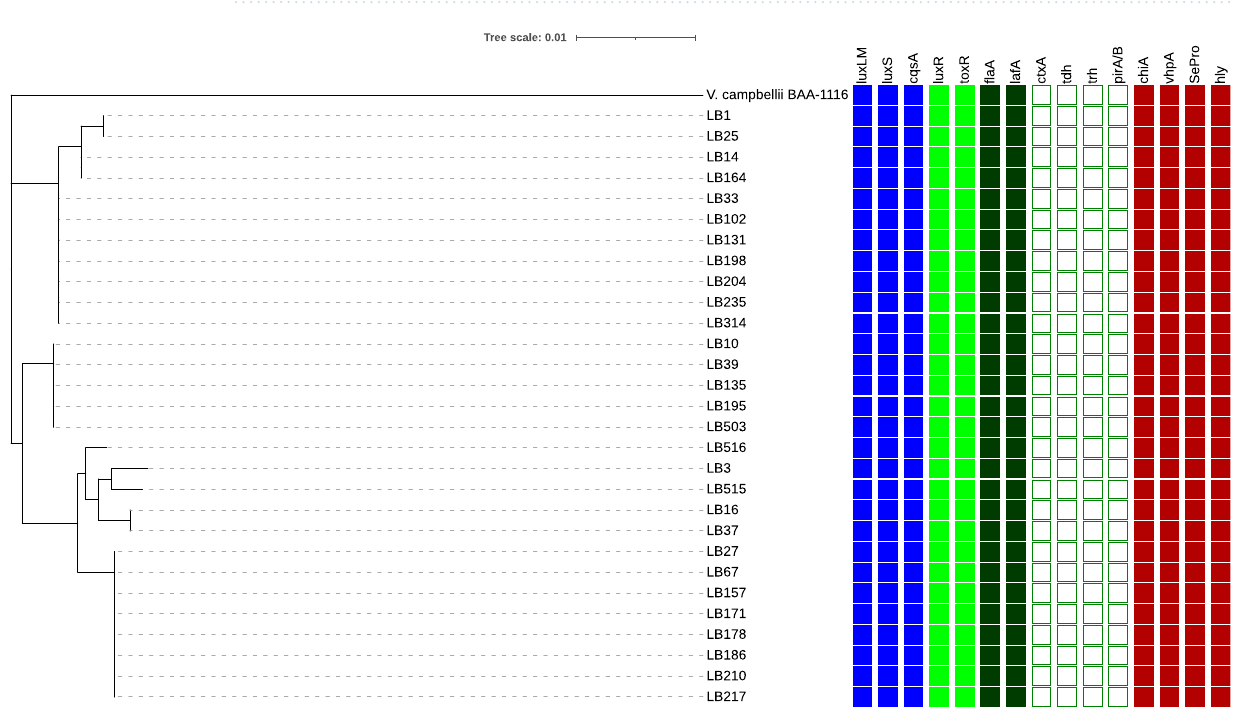
Figure 3. Syntenic gene organization of toxR gene loci in V. campbellii, V. cholerae and V. parahaemolyticus. HTPG: High Temperature Protein G (heat shock protein G); ADK: Adenylate kinase; FC: Ferrochelatase; DTPA: Dipeptide/tripeptide permease; RFAH: Transcription antitermination protein.